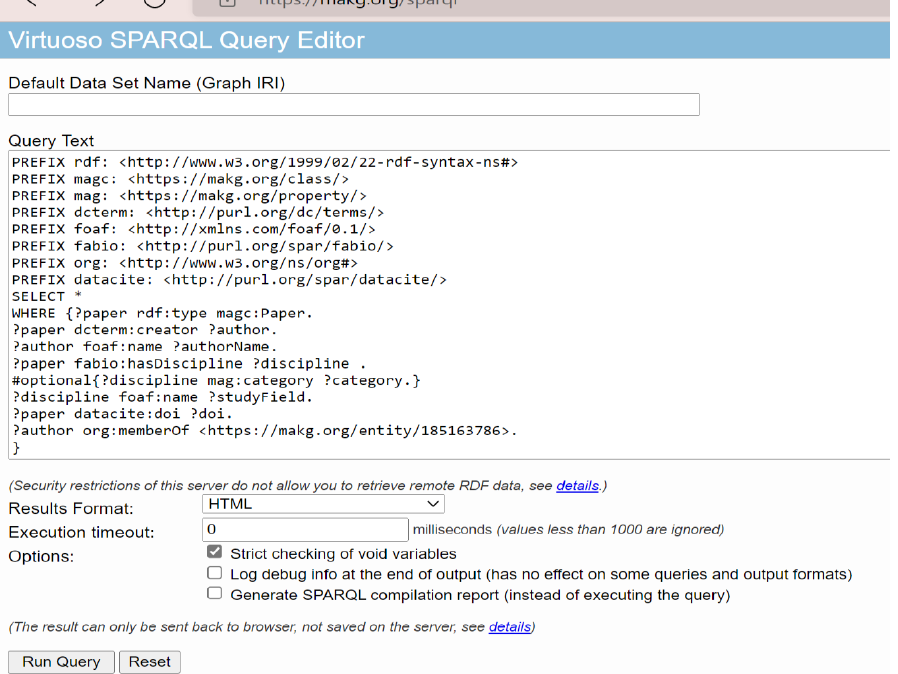
Figure 2. Count KAU researchers ’ profiles in MAKG.